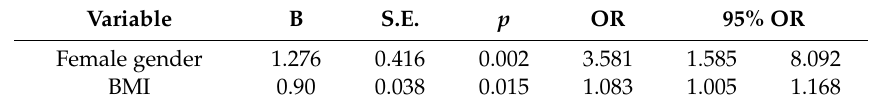
Table 4. Assessment of independent factors that predict thyroid disease for patients in